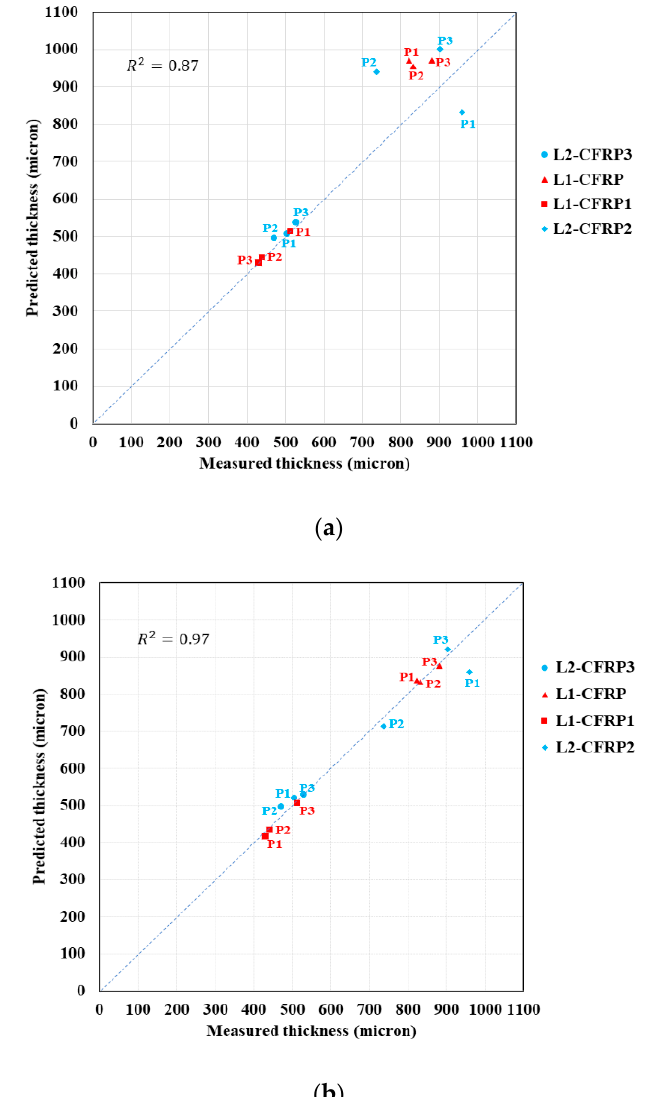
Figure 12. Measured and predicted thickness of CFRP plies at the head radius. ( a ) Constant friction coefficient. ( b ) Temperature-dependent friction coefficient.